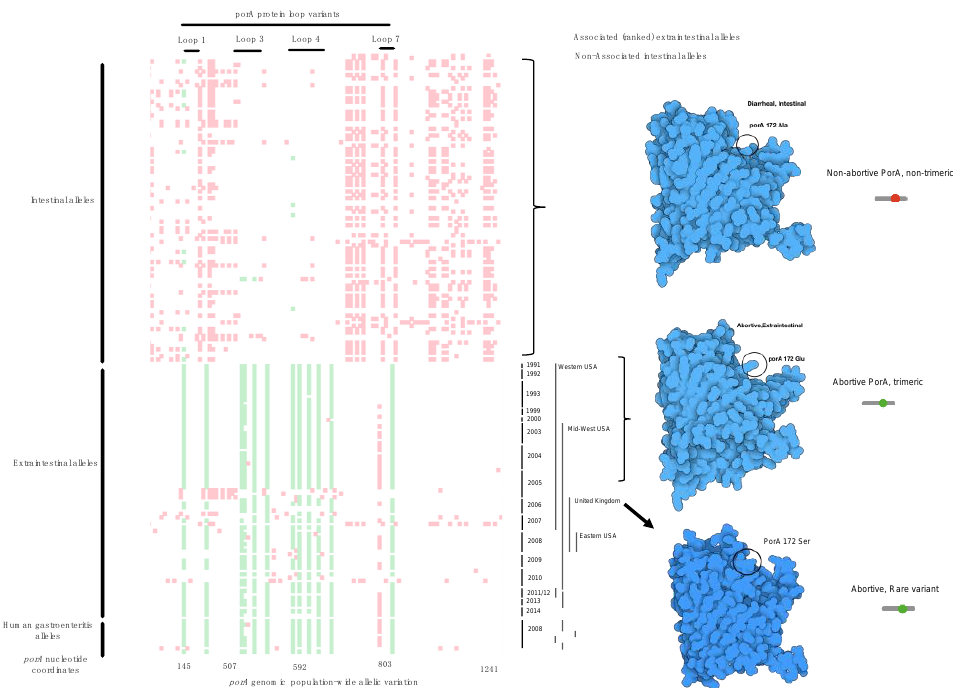
Figure 3. Comparative plot of SNP loci along the porA gene in all genomes. We termed this a Tetris plot as an alternative visualization of genome-wide association hits because they are ranked and display only the loci that vary to produce a non-synonymous mutation. The y -axis contains individual genomes from the cases and the controls, while the x -axis contains the GWAS SNP loci (green), the non-disease-associated SNPs (red), open space (white) are loci that are identical in the gene sequence. Temporal and geographic metadata on the right side of the Tetris plot provides context for mutational enrichment over 30 years and multiple distant locations in North America and the UK. The enriched SNP variation produced different protein structures (far right in blue) as the corresponding protein model by location within the animal by SNP. Protein structural features corresponding to the ranked GWAS variants are annotated on top, and below the plot are the nucleotide coordinates. Rare variants (homology < 75%) were not included by the variant caller in this visualization, but manual inspection provided a method to find these variants.